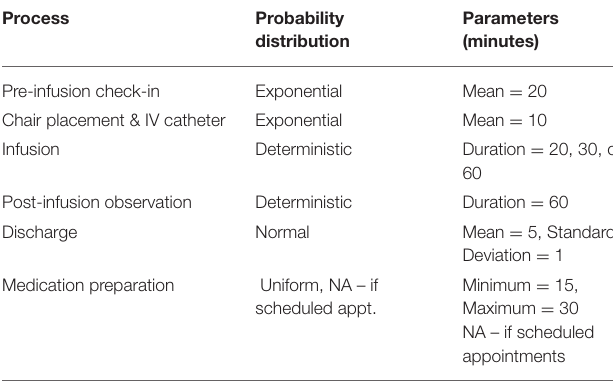
TABLE 2 | Probability distributions and parameters for mAb treatment sub-processes.